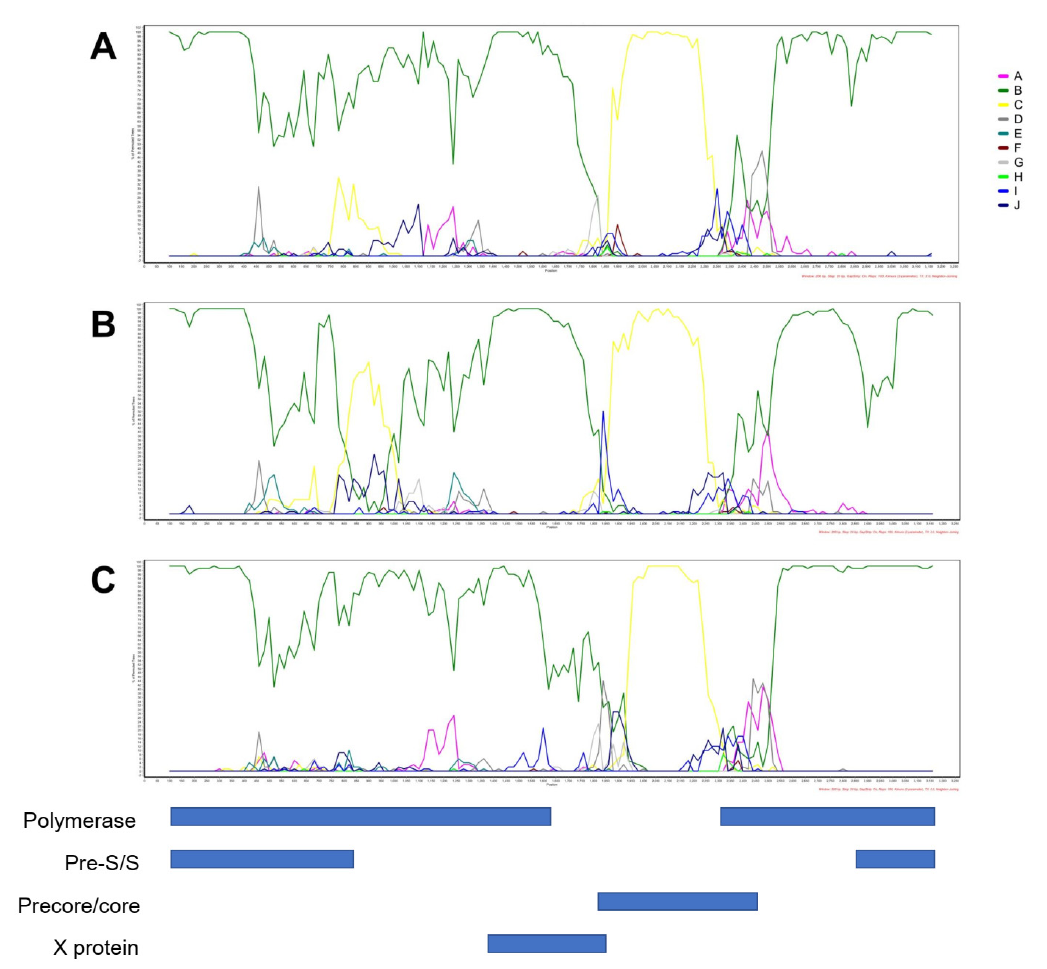
Figure 2. BootScan analysis over nucleotide position along the HBV genome for samples ( A ) HBV 3, ( B ) HBV 7, and ( C ) HBV 13. The y axis shows the percentage of permuted trees in which the selected HBV genotypes clustered with the query sequence. Genotypes were colour-coded.